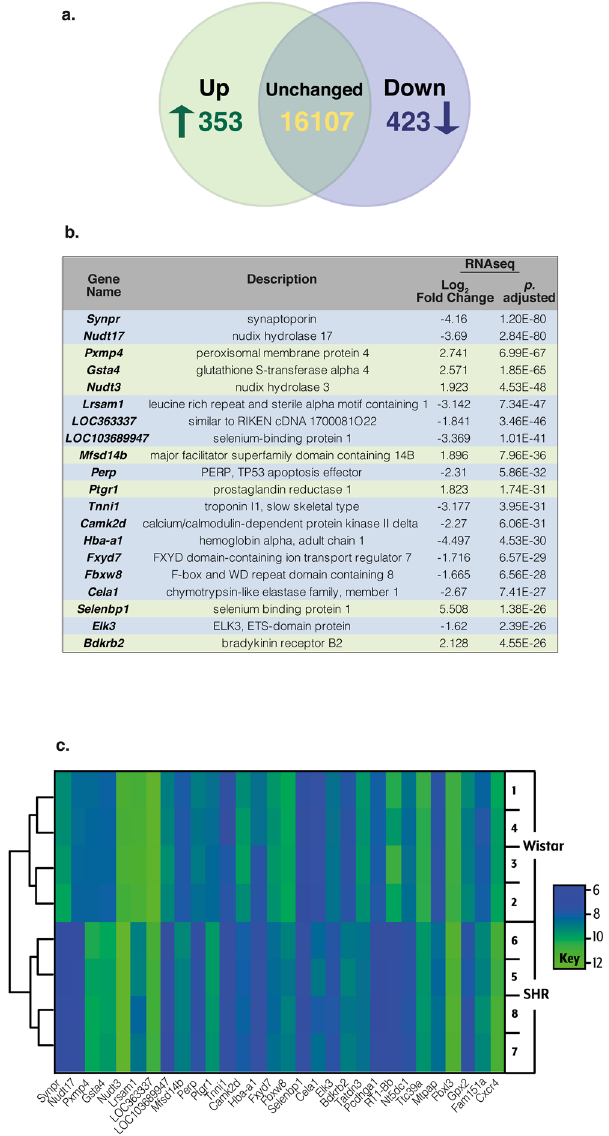
Figure 2. Overview of the differentially expressed genes in the stellate ganglia. The Venn diagram represents the total number of upregulated gene transcripts (353) and downregulated transcripts (423) in the SHR stellate ganglia, identified by DESeq2 analysis ( a ). The top differentially expressed transcriptomic changes between Wistar and SHR sympathetic stellate ganglia are listed; where green and blue represent up- and downregulated genes respectively ( b ). The heat-map represents the expression levels of differentially expressed genes in Wistar and SHR stellate ganglia. The colour legend indicates similarity of gene expression between samples. The colour gradients of samples indicate the inter-sample similarity of transcript expression for a particular gene. The dendrogram depicts overall similarity of the samples within this geneset, highlighting the distinction between strains as well as between samples within strains ( c